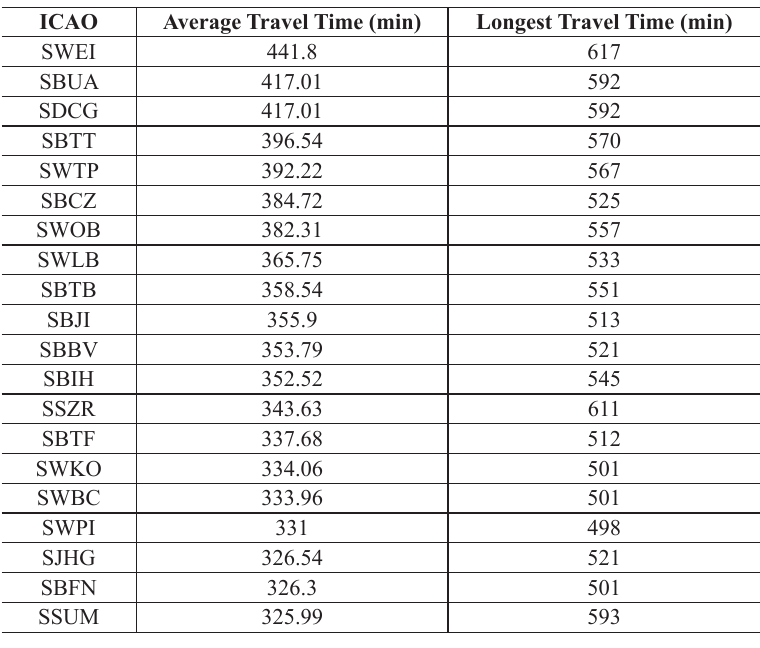
Top-20 largest average time of all paths in the air transportation network.